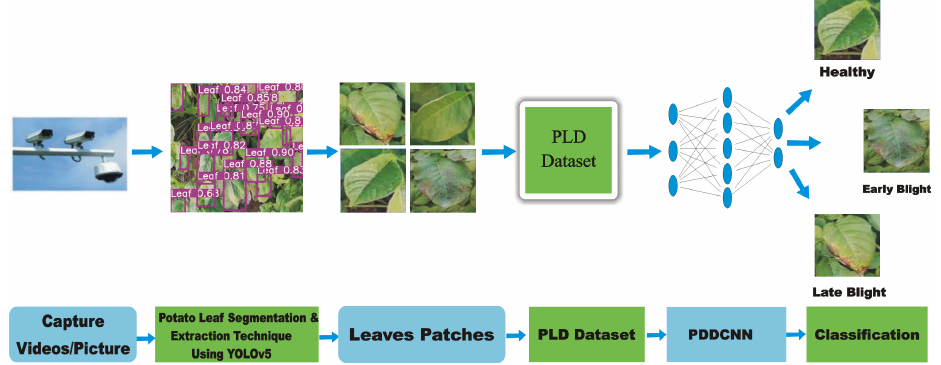
Figure 2. The overall architecture of the proposed